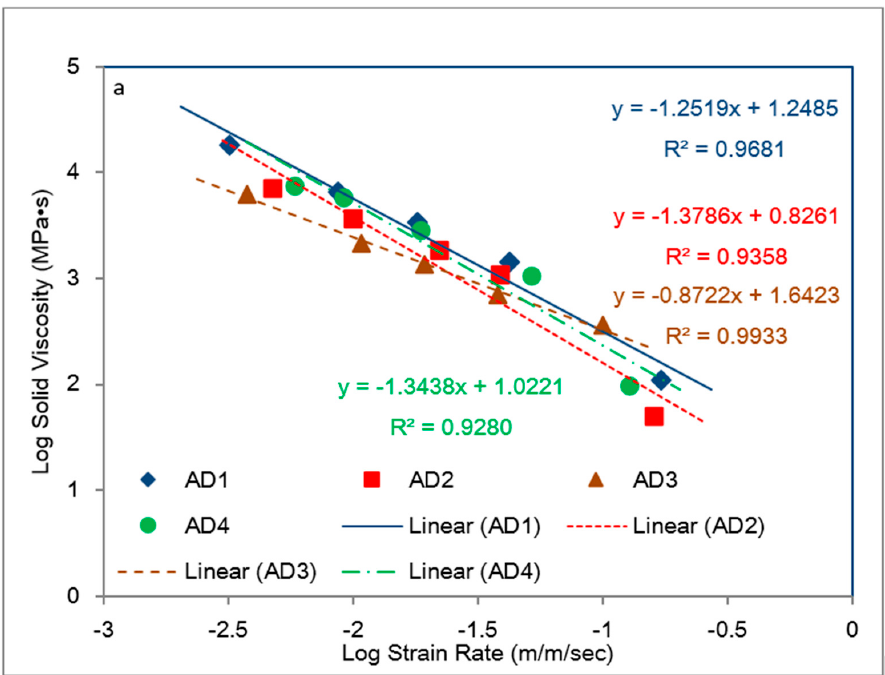
Figure 19. Variation of the solid viscosity, µ , fitted based on the bilinear-viscoelastic model as a function of strain rate during tensile tests.